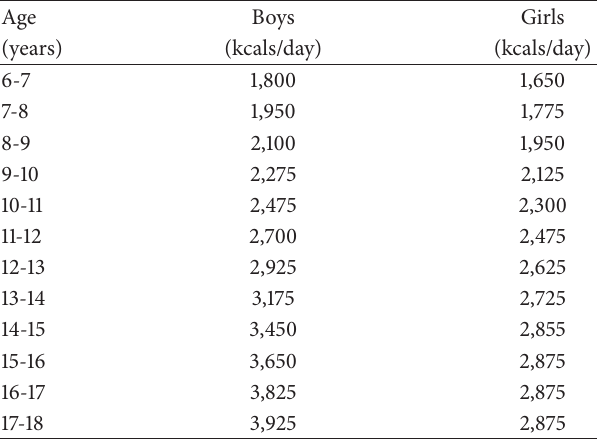
Table 1: Age-specific energy requirements for boys and girls who participate in heavy physical activity